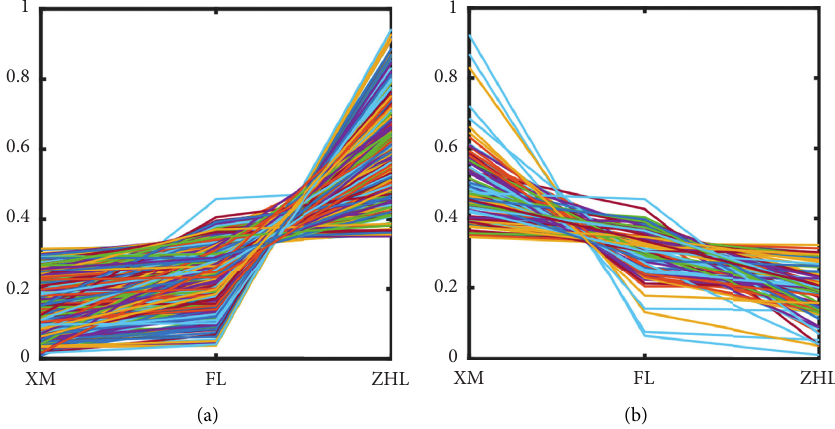
Figure 7: The in turn up- (a) and downregulated (b) expression proteins in the annual branches of the three varieties of